Question: Write a descriptive caption for this figure.
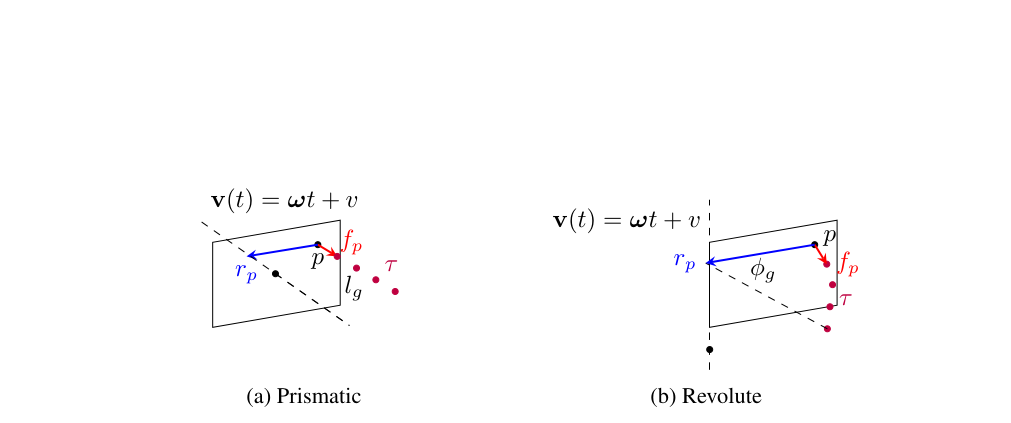
Answer: For each point p on the object, Articulation Flow fp [6] represents its instantaneous motion under a force in the opening direction; our new representation, Articulation Projection rp, represents the displacement that projects p to the articulation axis v. We train a network to predict both fp and rp and combine their predictions to get a smoother and more robust estimate. The purple points represent an interpolated prismatic trajectory of length lg and an interpolated revolute trajectory of ϕg angle rotation. This corresponds to the trajectory prediction described in Sec. 4.2.